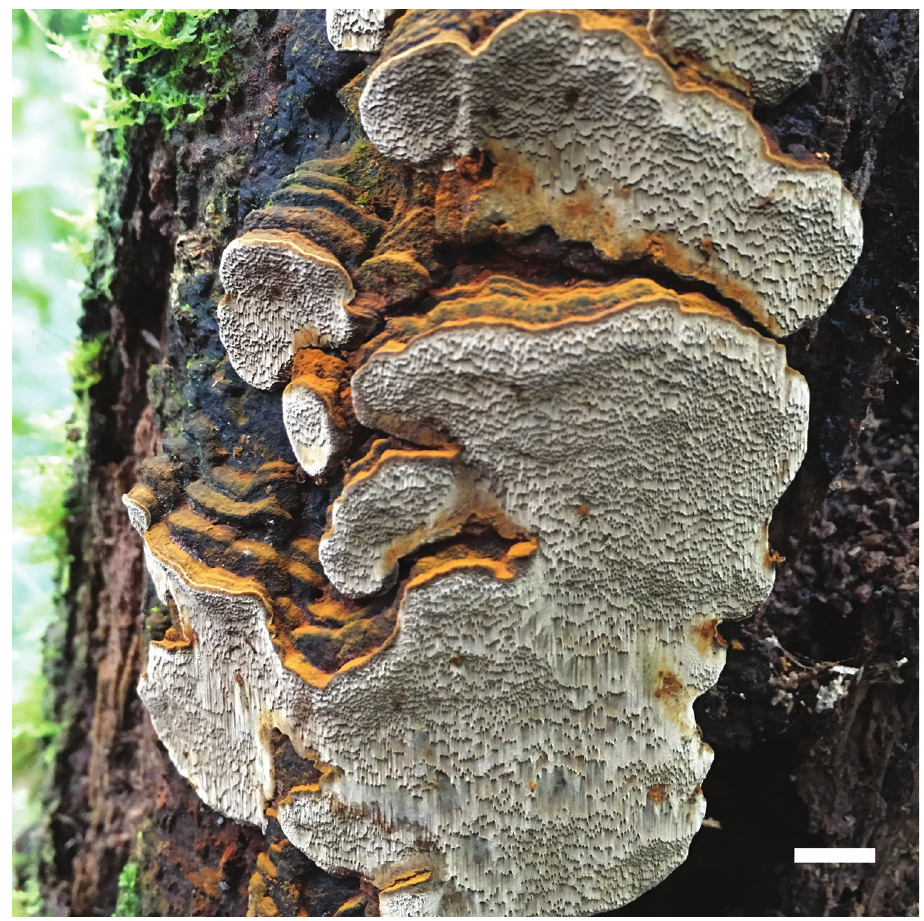
Figure 7. Basidiomata of Fomitiporella vietnamensis . Scale bar: 1